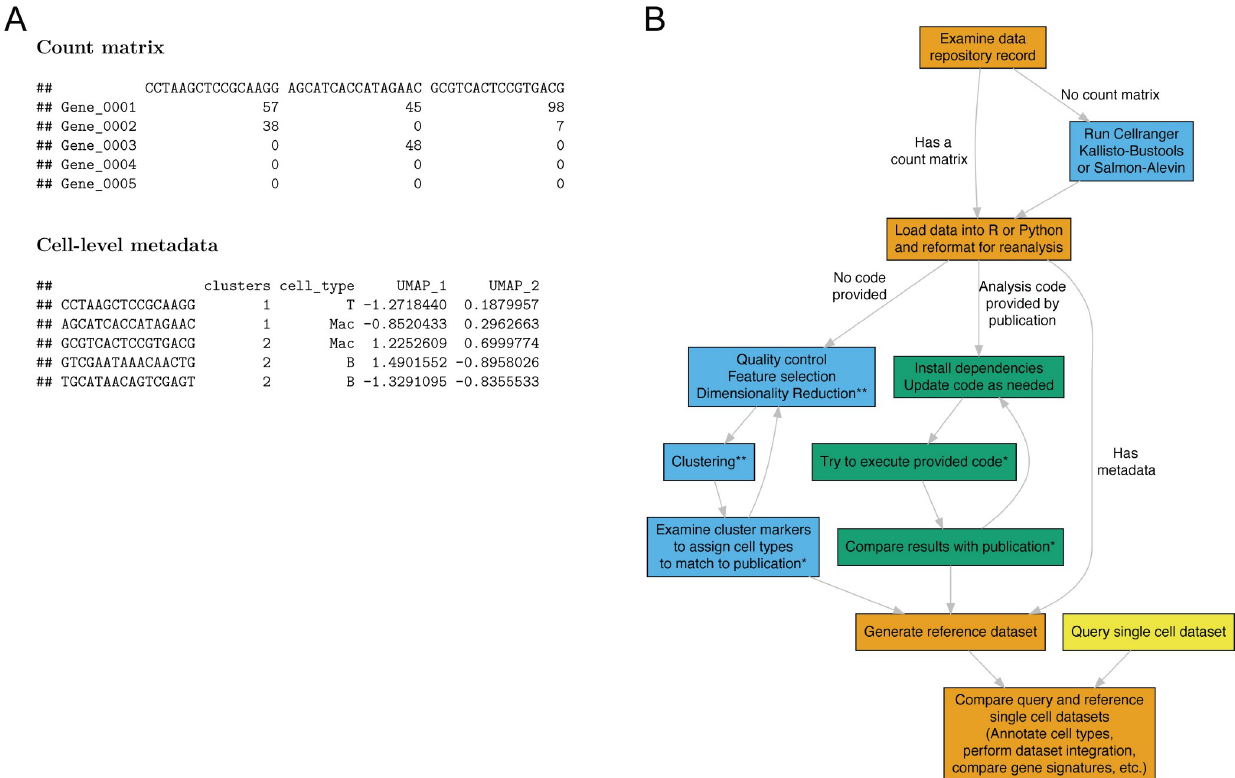
Fig 1. Processed data files necessary for replicating single-cell studies. (A) Example of a gene-by-cell count matrix containing single-cell measurements and a cell-level metadata table containing annotations inferred from the analysis of the single-cell dataset. (B) Workflow of analysis steps for regenerating cell type or gene-expression signatures from public datasets for comparative analysis of single-cell datasets. � indicates a step requiring an analyst to make subjective decisions; �� indicates a step that often includes a nondeterministic algorithm.